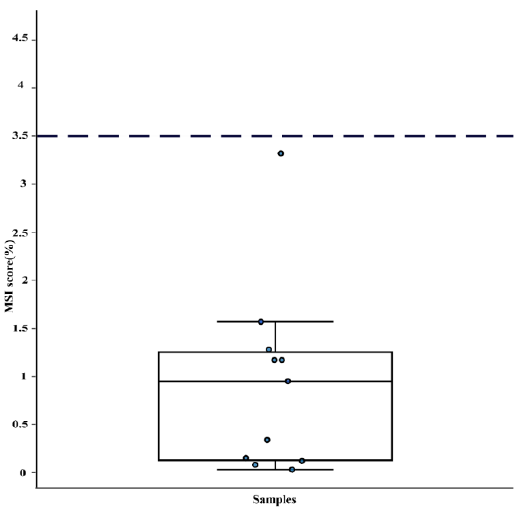
Figure 3. Microsatellite instability (MSI) scores for 11 anaplastic thyroid cancer cases. The dotted line represents the threshold to classify a case as MSI positive. Only one case was borderline MSI positive.